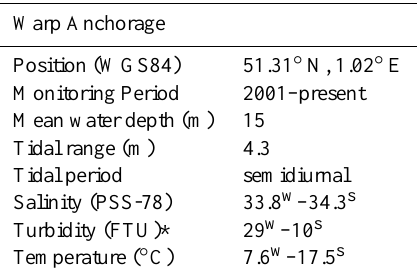
Figure 2. Validation of ECMWF MACC reanalysis 10m wind speed vs. height-corrected shipborne anemometer wind speed. forced with European shelf area constituents